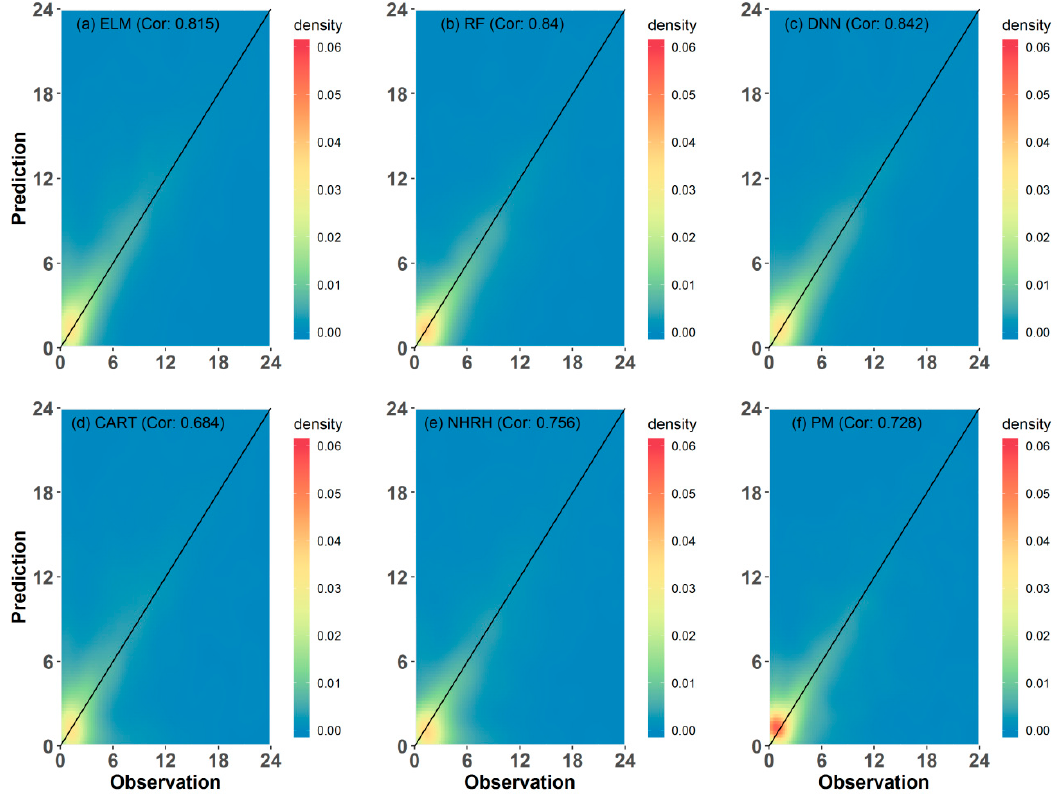
Figure 6. Quantile ‐ Quantile plots of six LWD prediction models without null wind speed data. Note that the correct predictions of zero values for LWD and data having null wind speeds are excluded.